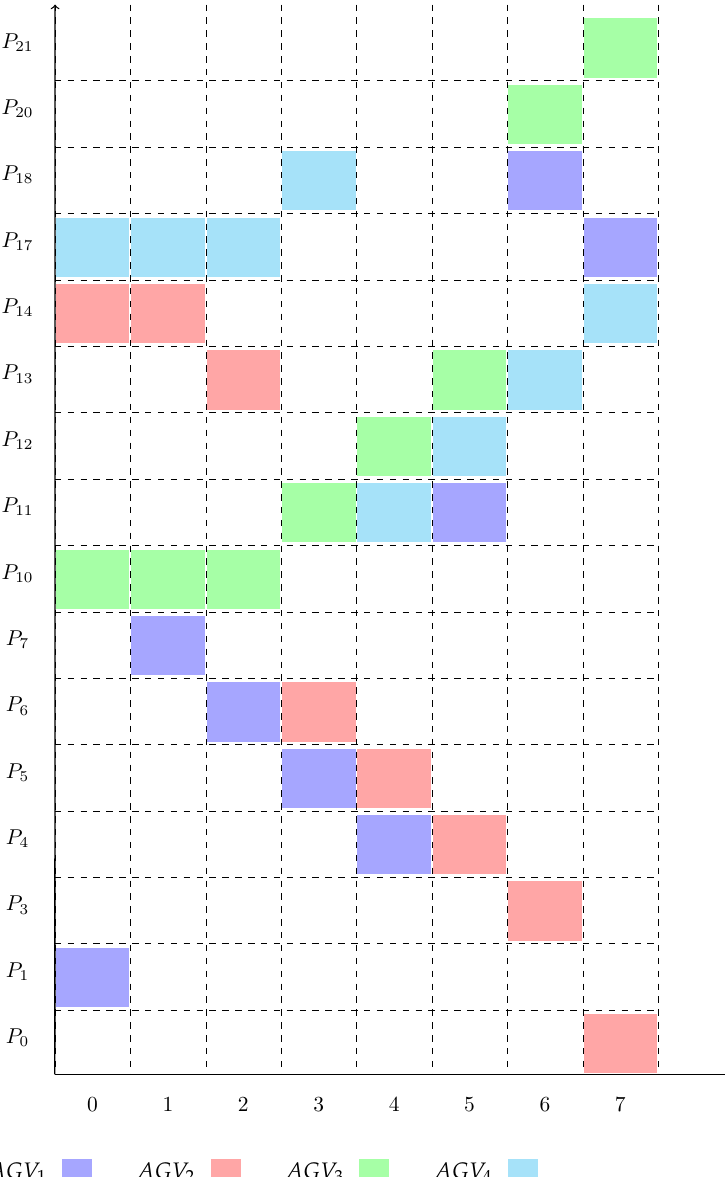
Figure 5. Initially computed solution: places held by the AGVs in each time instance. Moreover, since the road between P 4 and P 11 was later in the blocked state (at Time Instance 4 by O 2 ), AGV 1 required stepping backwards to P 6 and moving through the route between P 6 and P 13 . The passage through P 12 and P 13 (free after Time Instance 4) was then used by AGV 1 . It is worth pointing out that obstacle O 3 did not affect the outcome of the